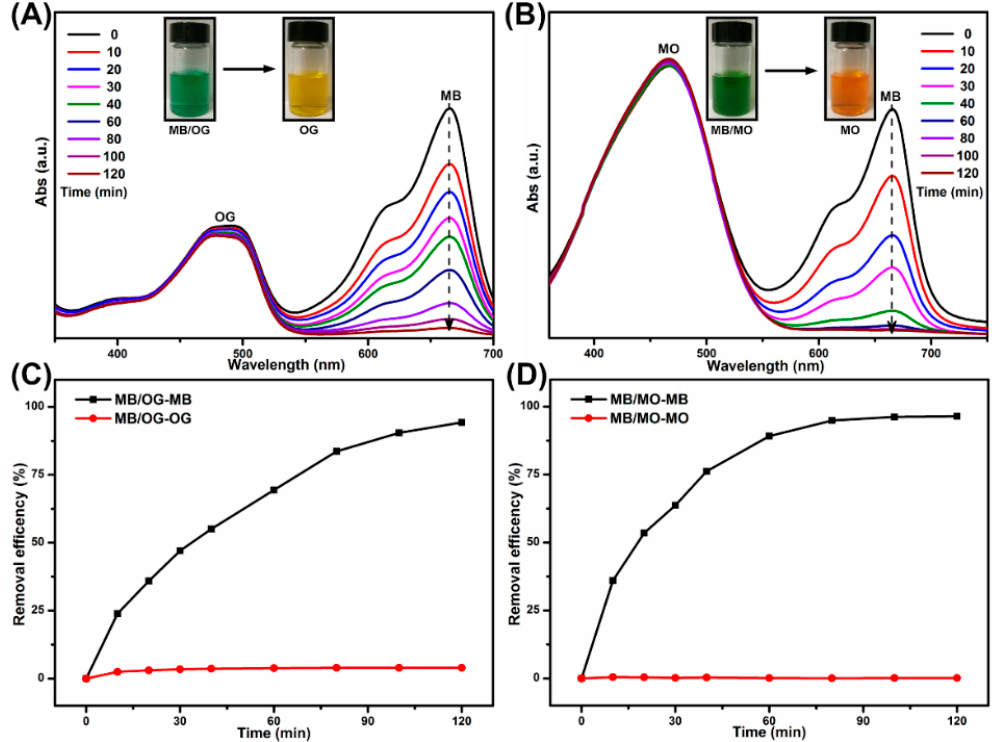
Figure 5. The UV-vis spectra and the corresponding removal efficiency of MB/OG mixture ( A ) ( C ) and MB/MO mixture ( B ) ( D ) onto SPEN-Al-2 at different contact times.